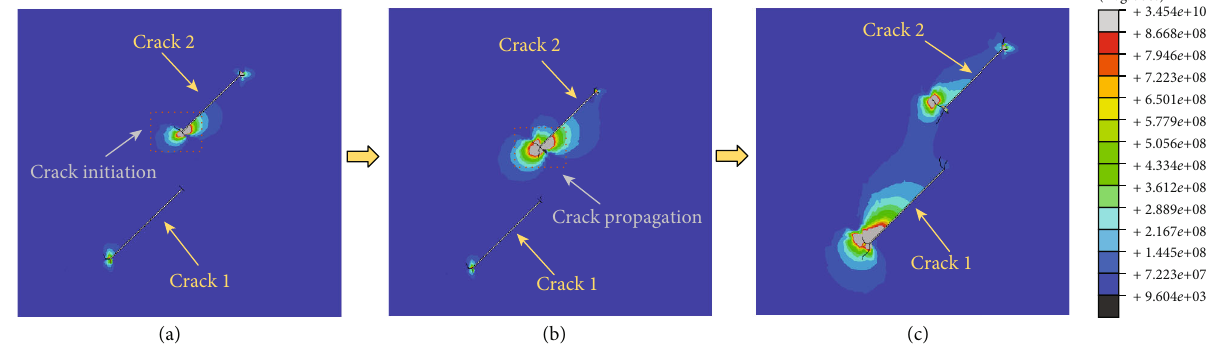
Figure 15: Model 5 stress distribution in numerical simulation. (a) t = 1 : 9 s . (b) t = 3 : 5s . (c) t = 4 : 5 s .